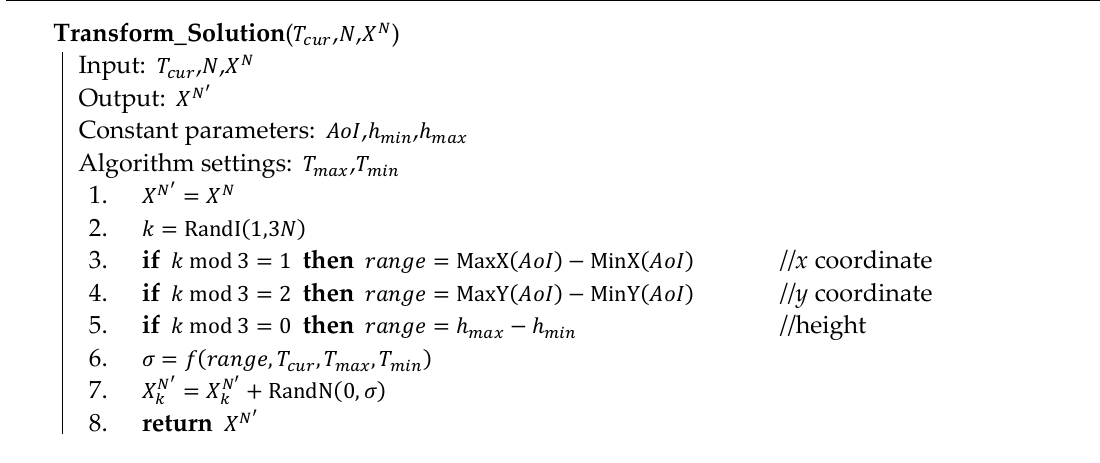
Algorithm 5 Transformation of a solution in pseudocode